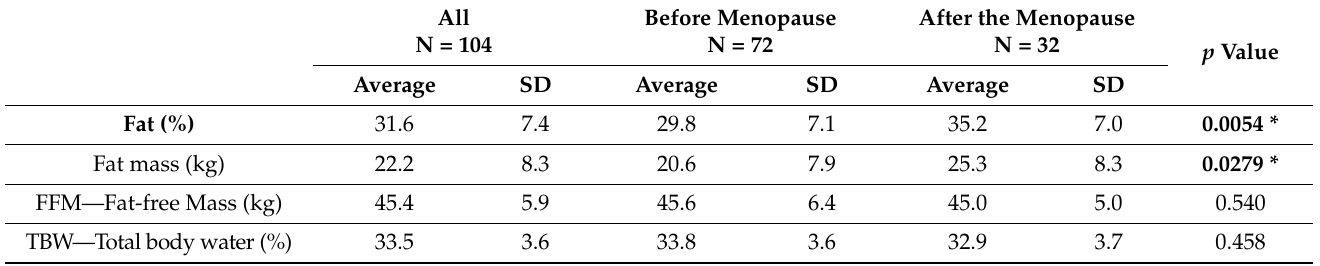
Table 3. Mean concentrations of body composition analysis parameters according to hormonal status.